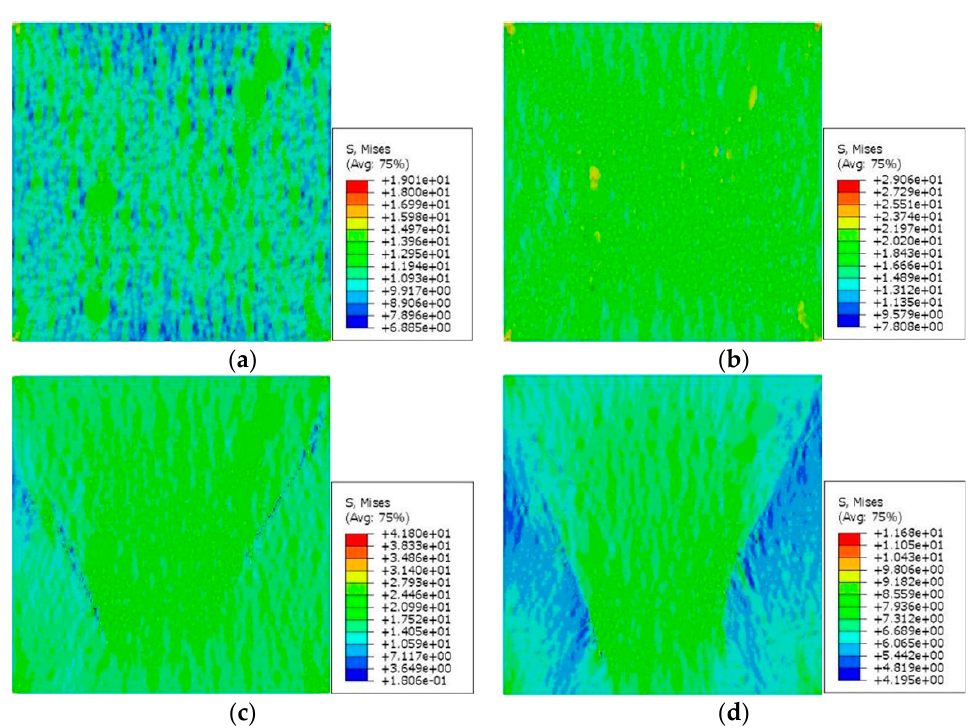
Figure 13. Stress nephogram of 2D RCA model for mortar (M1) with different strains: ( a ) ε = 0.03%; ( b ) ε = 0.1%; ( c ) ε = 0.3%; ( d ) ε = 0.45%.